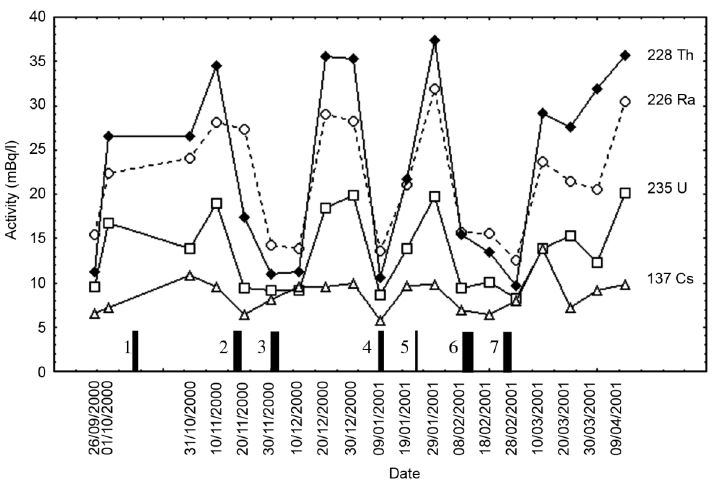
Fig. 6. Variation of activity of some radionuclides. Lower activities correspond to T / S peaks and are indicative of shallower water mass, as suggested by helium and its isotopic ratio.